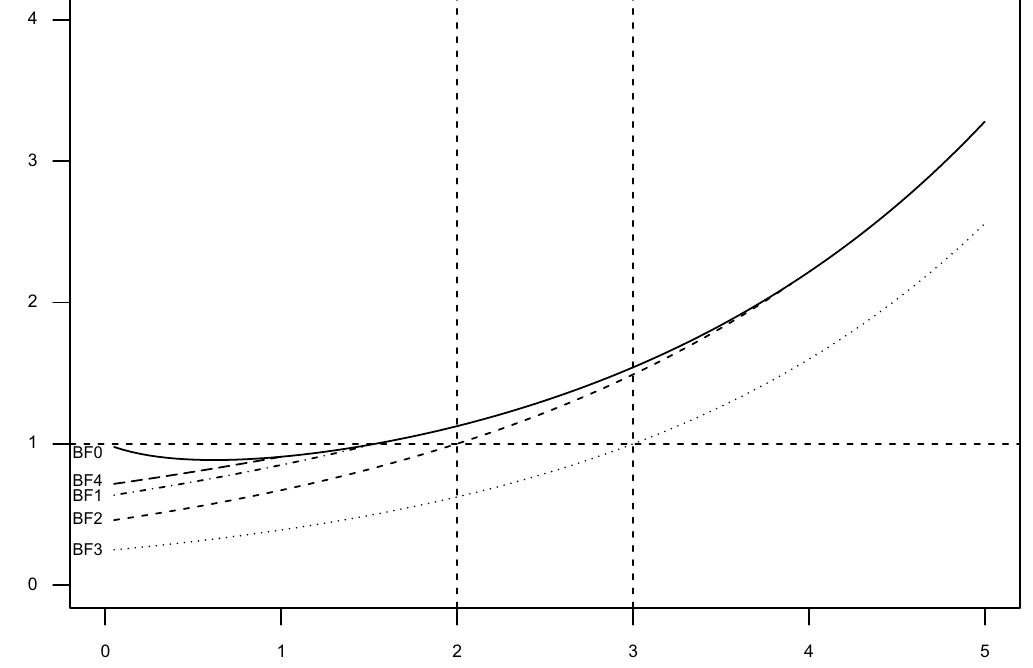
1 , BF2: (cid:31) 0.255 , BF3: (cid:31) = =